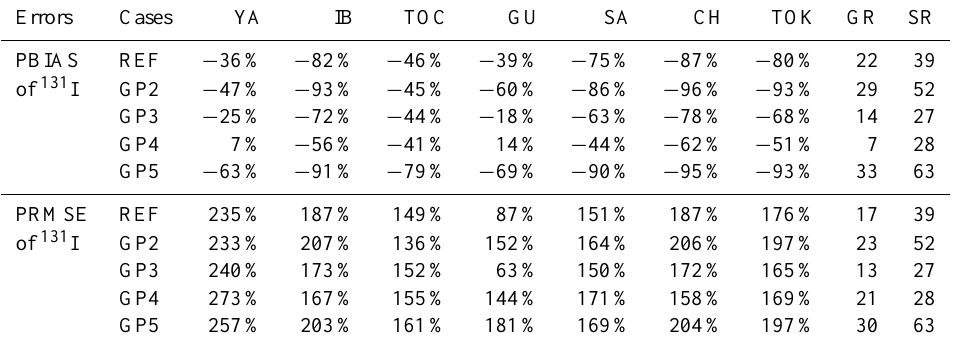
Table 9. The PBIAS and PRMSE of total daily depositions of 131 I with different gas partitioning of 131 I. GR represents the global ranks for PBIAS or PRMSE, and SR represents for the sum of the global ranks. The definition of GR and SR is shown in Sect. 3.1.2. “YA”, “IB”, “TOC”, “GU”, “SA”, “CH” and “TOK” represent the stations “YAMAGATA”, “IBARAKI”, “TOCHIGI”, “GUNMA”, “SAITAMA”, “CHIBA” and “TOKYO”,